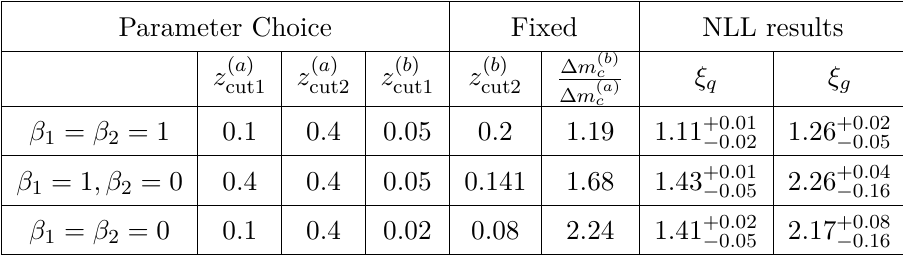
, and z ( b ) parameters. For our choice of p T = 800 GeV, cut1 cut i and the ratio of jet mass bins for sets ( a ) and ( b ) , cut2